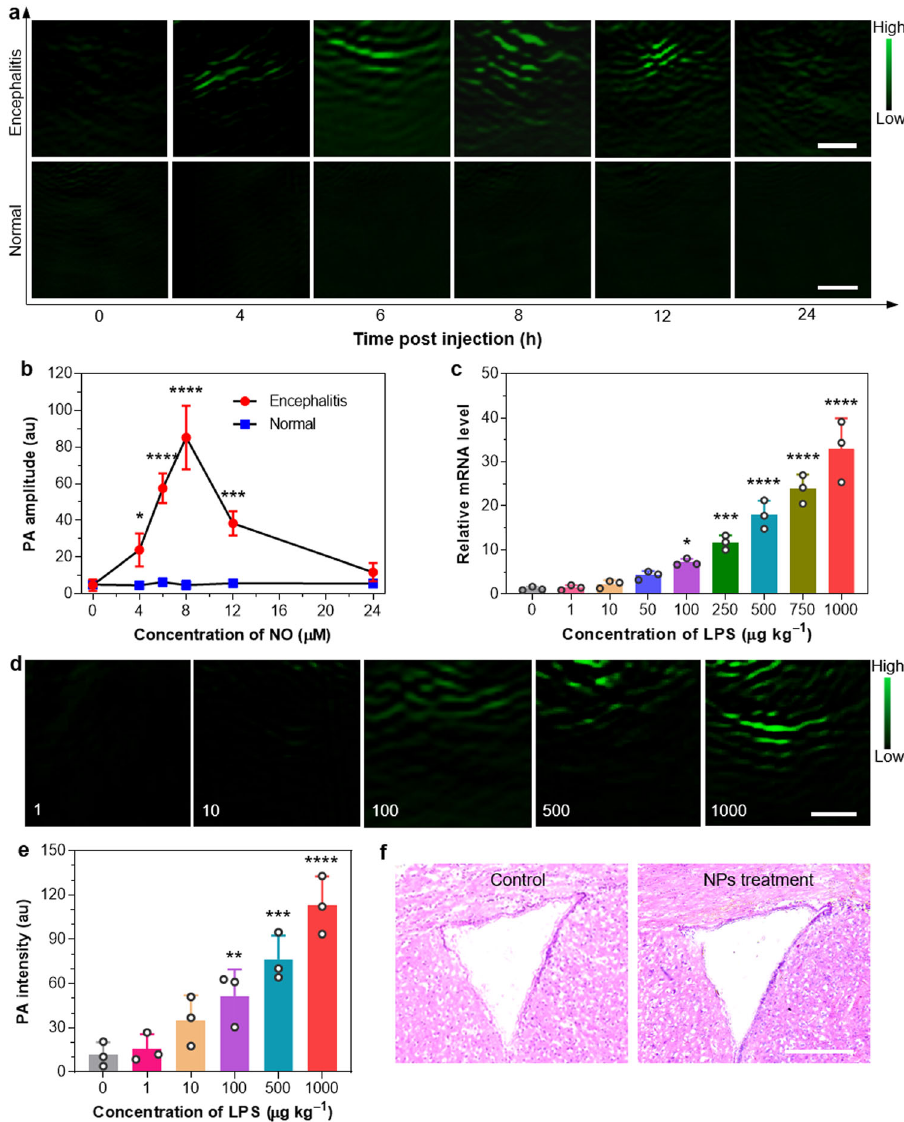
Fig. 6 In vivo PA imaging of encephalitis in different severities. a Representative in vivo noninvasive PA images and b the corresponding PA intensity of saline-treated brain (normal) and LPS-induced encephalitis after infusing OTTAB NPs at different time points as indicated. Scale bars: 1 mm. c Relative inducible nitric oxide synthase (iNOS) mRNA level at the disease site versus the concentration of injected LPS. d Representative in vivo noninvasive PA images and e corresponding PA intensity of the mouse brains treated with different concentrations ( µ g kg − 1 ) of LPS as indicated after administrating OTTAB NPs for 8 h. Scale bar: 1 mm. Data are presented as mean ± s.d. ( n = 3 biologically independent mice per group) for b , c , e . f Histological H&E staining of the mouse brain without and with the treatment of OTTAB NPs. Scale bar: 250 µ m. Brain tissues were harvested from three mice in each group, and the representative images from each group are shown. * p < 0.05 (4 vs. 0: p = 0.028 in b ; 100 vs. 0: p = 0.021 in c ), ** p < 0.01 (100 vs. 0: p = 0.0082 in e ), *** p < 0.001 (12 vs. 0: p = 0.00087 in b ; 250 vs. 0: p = 0.00032 in c ; 500 vs. 0: p = 0.00025 in e ), **** p < 0.0001 (6 vs. 0: p = 1.7 × 10 − 5 , 8 vs. 0: p = 2.1 × 10 − 7 in b ; 500 vs. 0: p = 1.3 × 10 − 6 , 750 vs. 0: p = 1.7 × 10 − 8 , 1000 vs. 0: p = 7.9 × 10 − 11 in c ; 1000 vs. 0: p = 3.6 × 10 − 6 in e ) using one-way